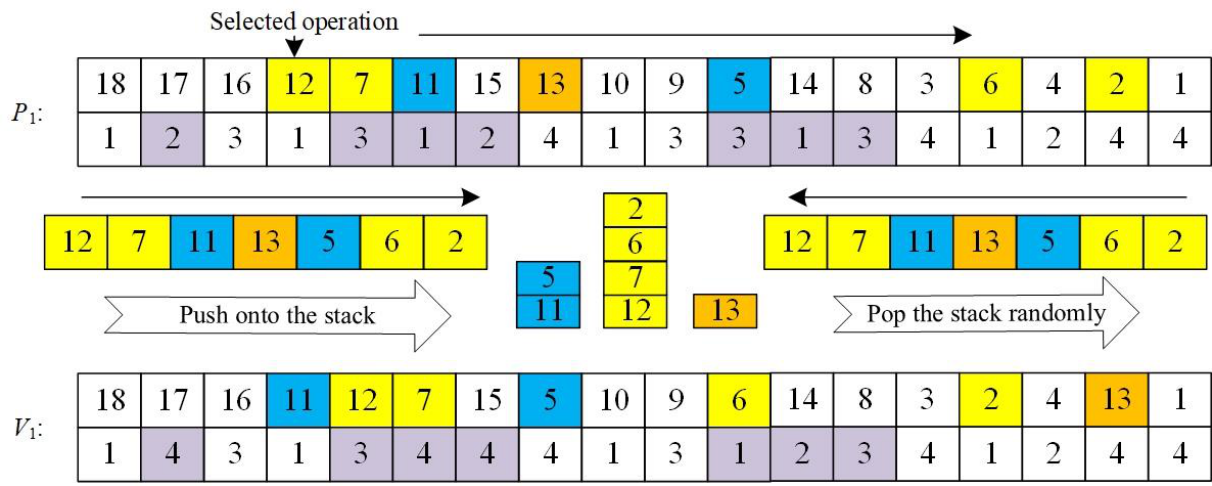
Figure 7. Schematic diagram of generating progeny individuals by applying the chaotic mutation method based on the sibling process.